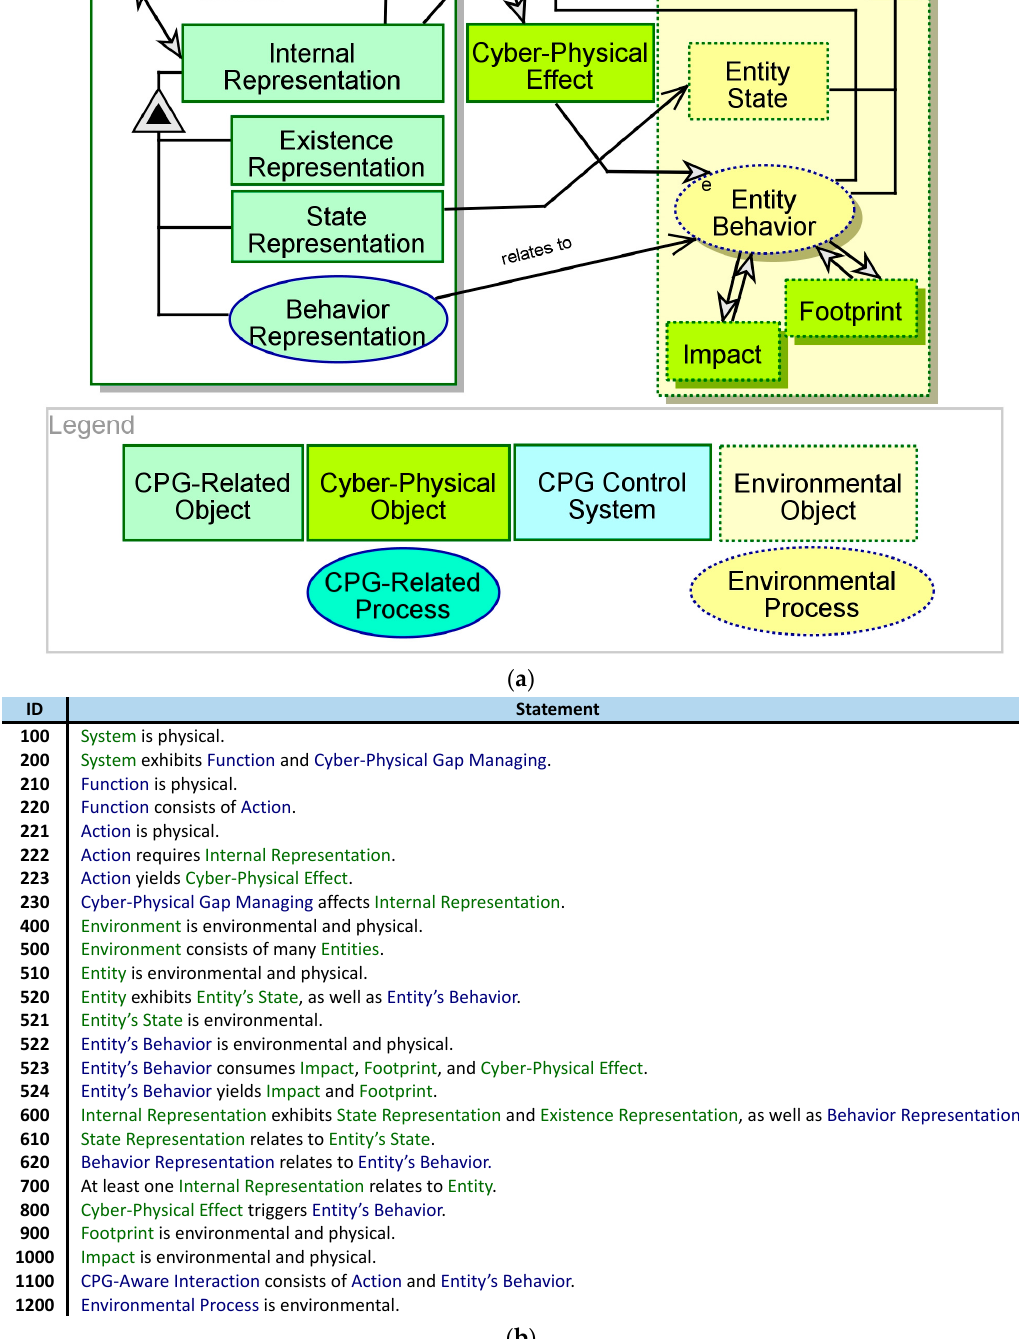
Figure 2. System Diagram (SD) ( a ) and its equivalent OPL text ( b ) of a CPG-aware system.